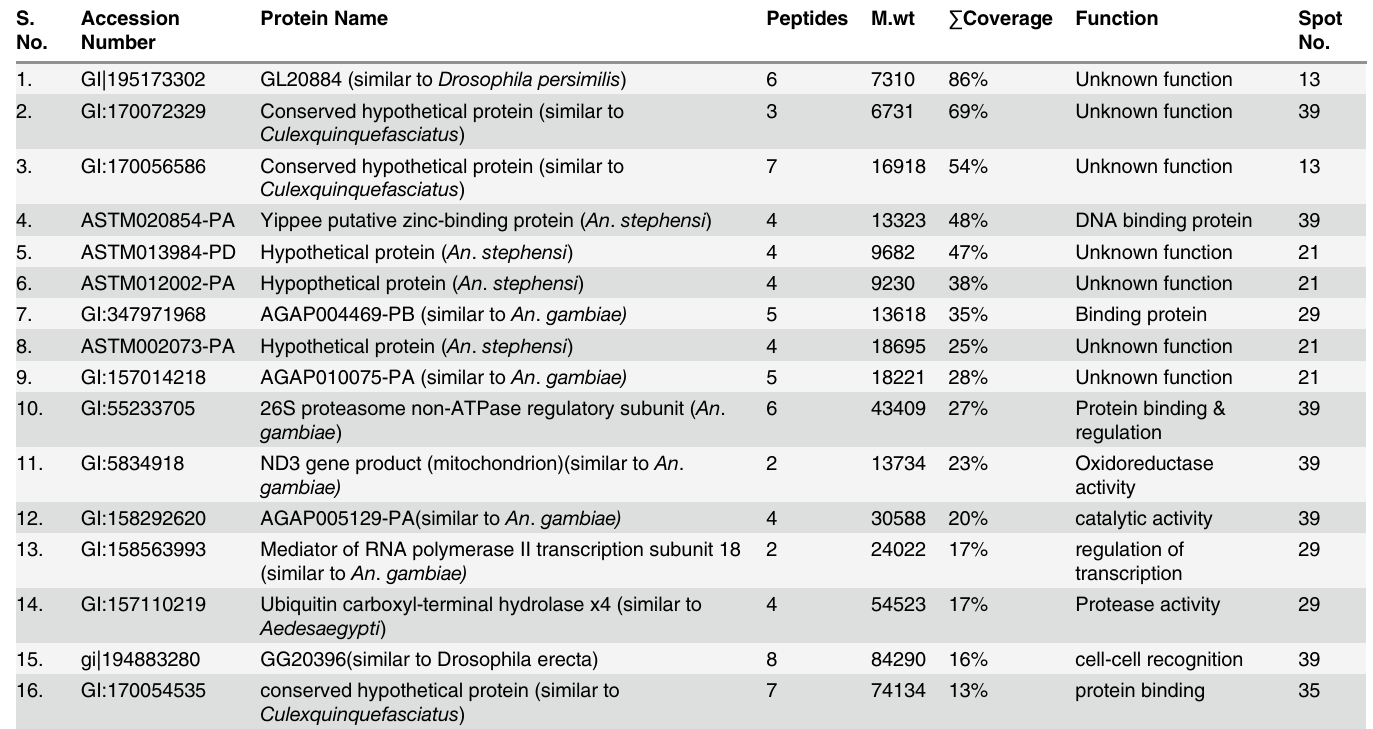
Table 3. Summary of down regulated salivary proteins identi fi ed in the SGE of An . stephensi multi resistant strain by MALDI-TOF MS. S. No.